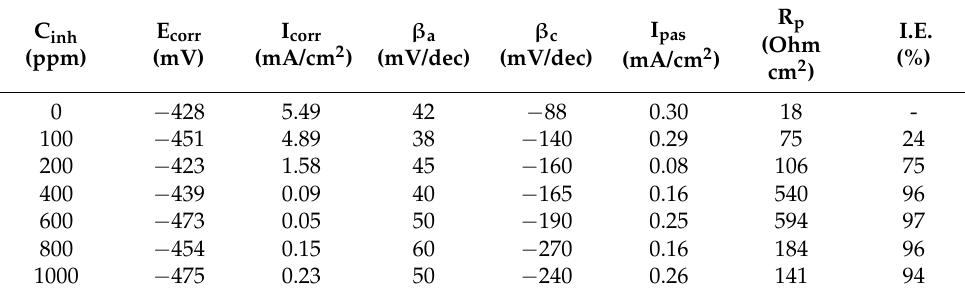
Table 2. Electrochemical parameters obtained from polarization